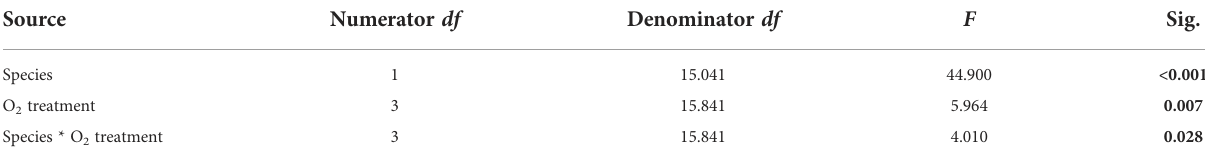
TABLE 5 Summary of results for LMMs comparing Chl a content between treatments for both